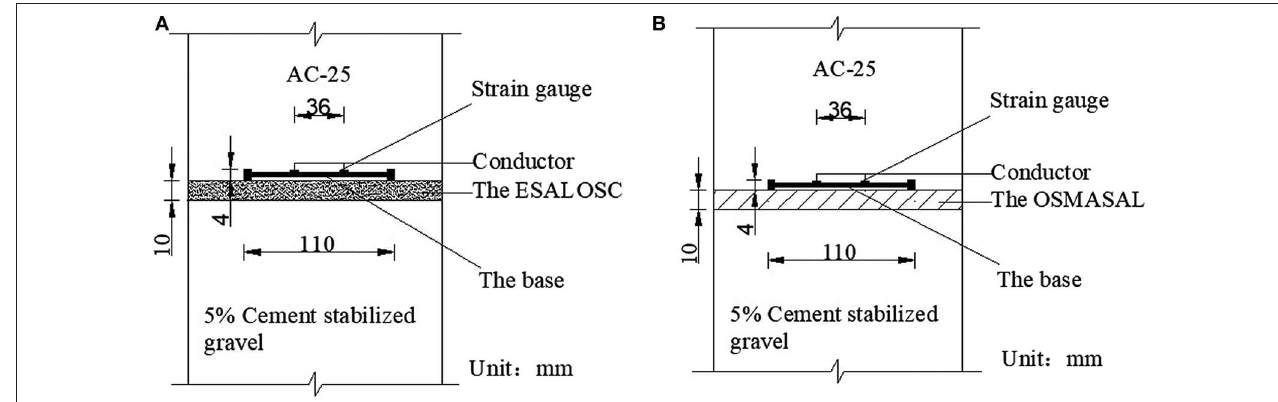
FIGURE 2 | (A) Sensor embedded position of the ESALOSC, and (B) sensor embedded position of the OSMASAL.